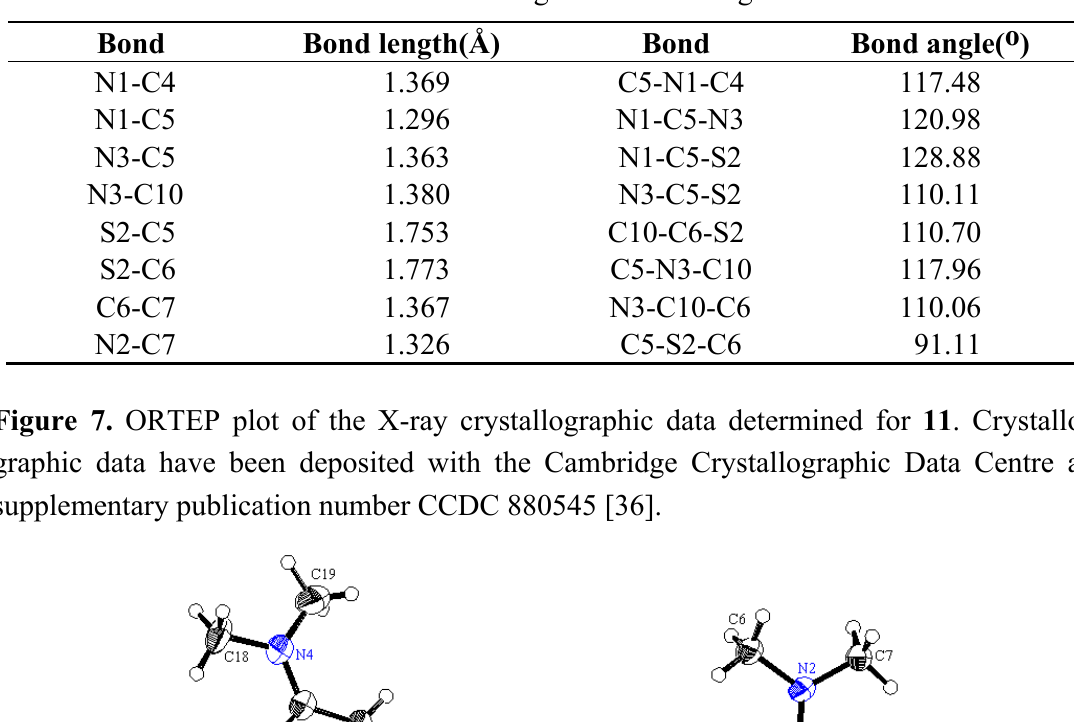
Table 3. Selected bond lengths and bond angles for 8b .